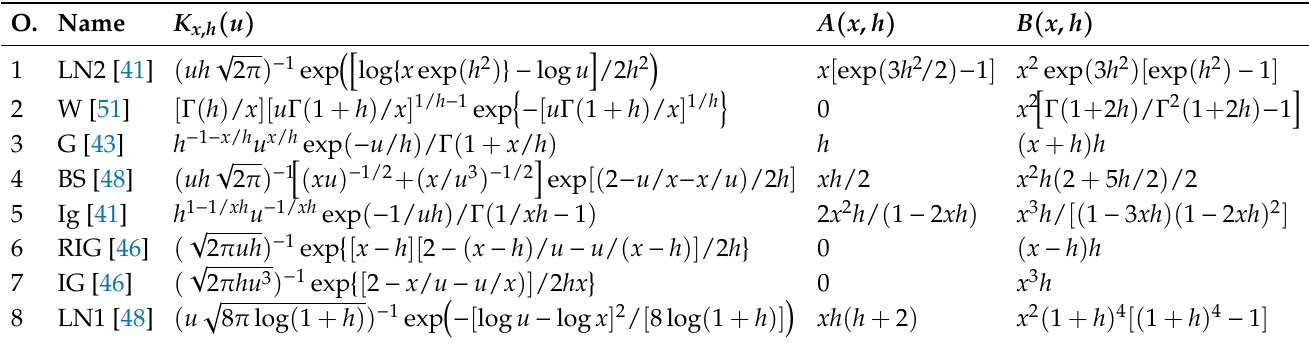
Table 1. Eight semicontinuous univariate associated kernels on S x , h ⊆ [ 0, ∞ ) and classifyed by “O.”